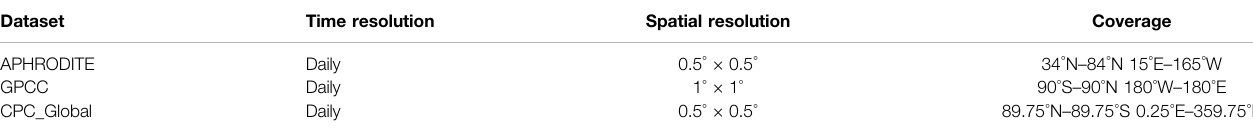
TABLE 2 | Information of three Gauge-Based precipitation products.